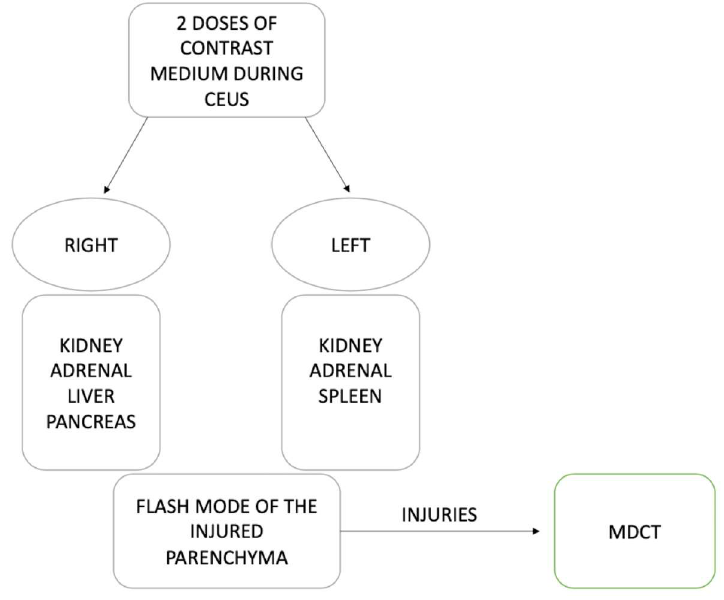
Figure 8. Low-grade trauma evaluated with CEUS.